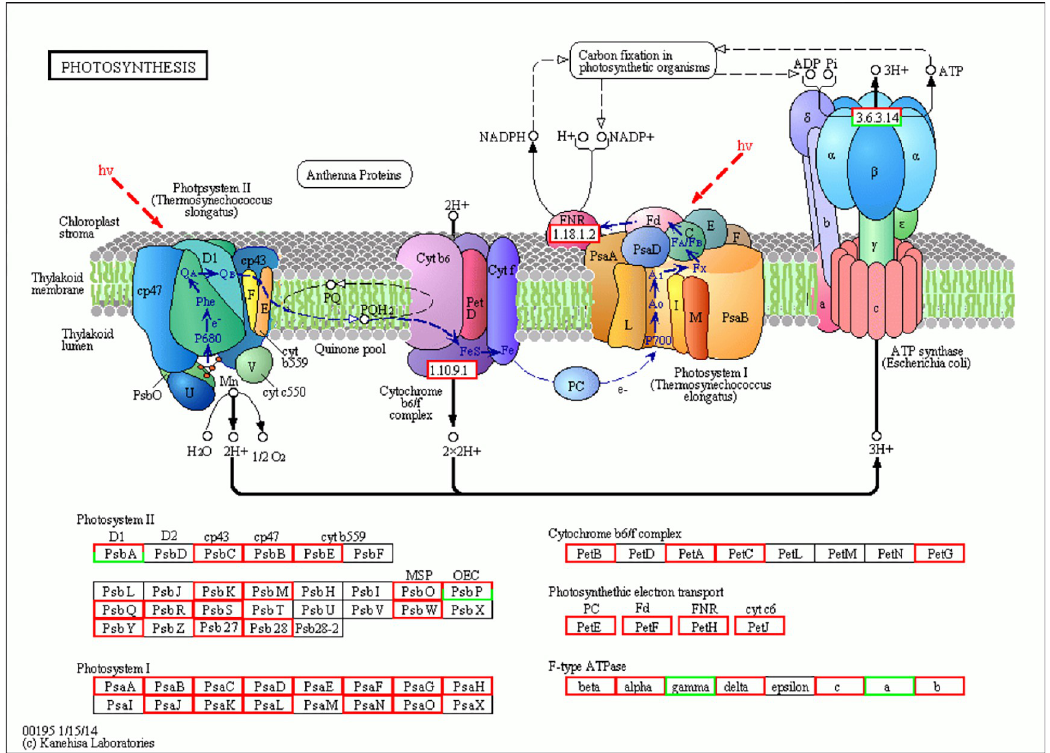
Fig 9. Forty DEGs (red) involved in the photosynthesis pathway were up-regulated in QianMei 419 compared to QianFu 4. DEGs (green) involved in the photosynthesis pathway were down-regulated in QianMei 419 compared to QianFu 4. Red and green boxes indicate genes whose expression levels were up and downregulated between QianMei 419 and QianFu 4. For interpretation of the references for the color in this figure legend, the reader is referred to the web version of this